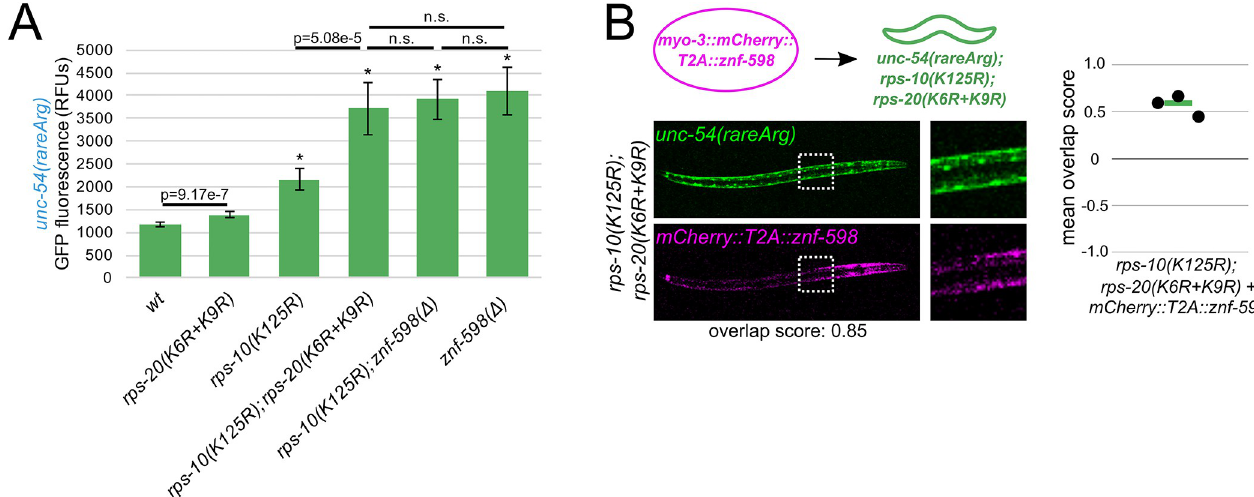
Fig 4. NGD-deficient ribosomes made via ablation of ubiquitination sites. (A) Mean RFUs (relative fluorescence units) of indicated strains (n � 15 animals/ strain) in the unc-54(rareArg) background. One standard deviation shown as error bars. p values from Welch’s t-test, with asterisks indicating p < 0.01 for all comparisons with wild type. (B) As in Fig 2, with znf-598 construct in rps-10; rps-20 strain.